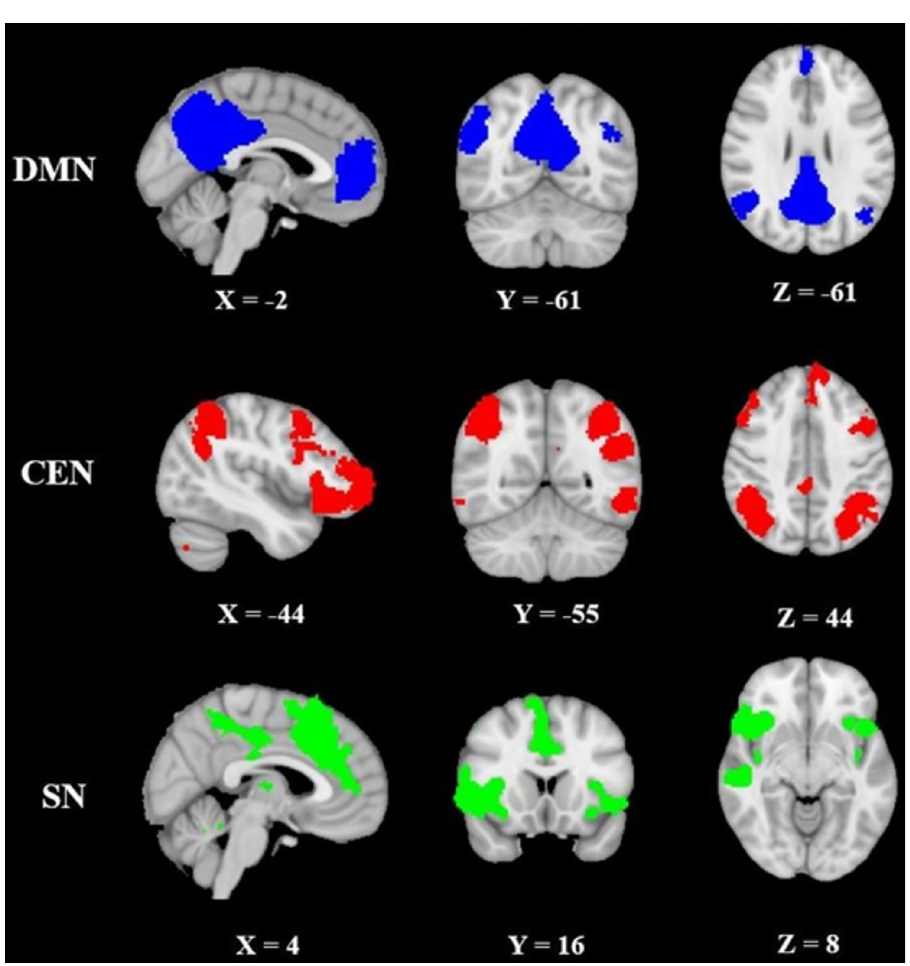
Fig 2. Depiction of the triple networks referred to as the triple network: Default mode network (DMN, blue colour), central executive network (CEN, red colour), and salience network (SN, green colour). The networks were identified by decomposing the pre-task resting-state condition into 20 components from 21